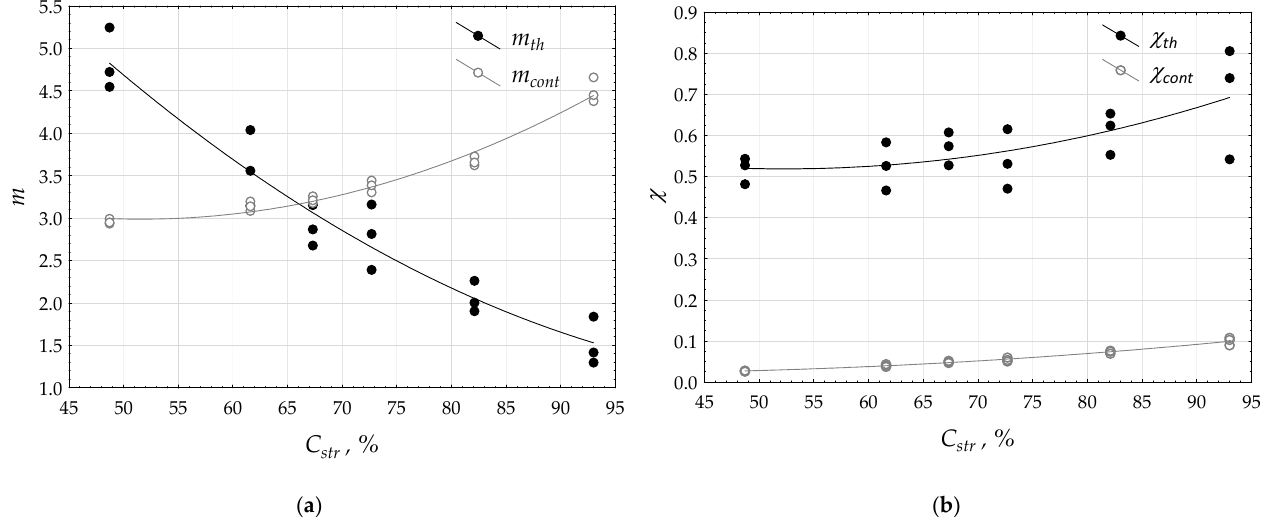
Figure 8. Influence of percentage surface cover on: ( a ) phase exponent; ( b ) phase connectivity. The results of the measurements were approximated by quadratic polynomials. Coef- ficients of determination R 2 were as follows for m th = f(C str ) – R 2 = 0.908, and for m cont = f(C str ) – R 2 = 0.854 (Figure 8a); for χ th = f(C str ) – R 2 = 0.417, and for χ cont = f(C str ) – R 2 = 0.936 (Figure 8b). All the coefficients were significant at the 0.10 significance level. It was found that the percentage surface cover increase caused an increase in connectivity of each phase. An increase in percentage surface cover caused a decrease in the strips’ phase exponent and an increase in the strip contacts’ phase exponent. Each of the phases that occupy the